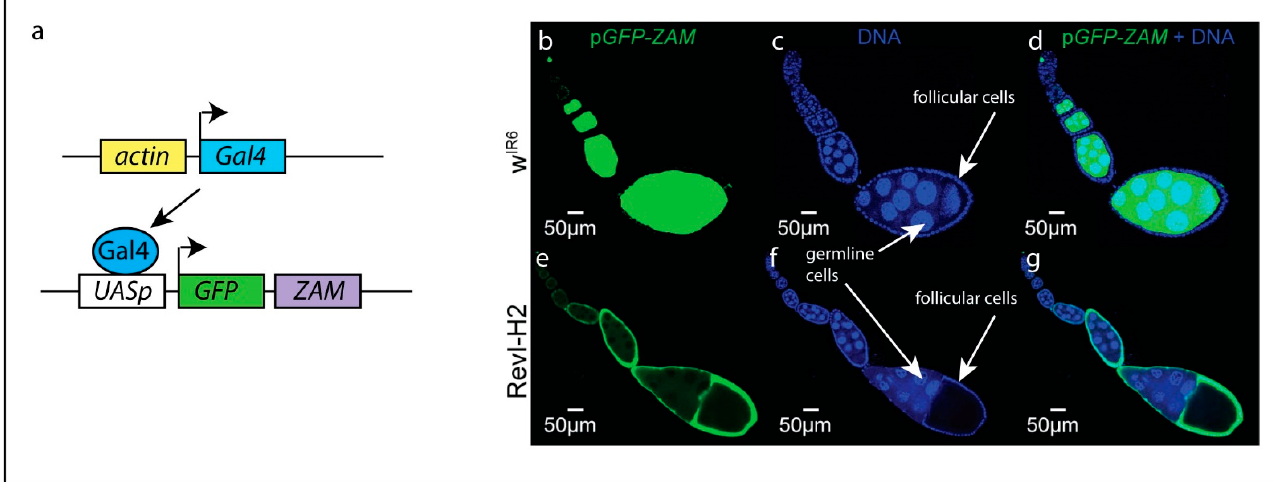
Figure 2. Regulation of the retrotransposon ZAM by piRNAs. ( a ): Principle of the ZAM sensor. Expression of the trans- activator Gal4 is ubiquitously driven by actin regulatory sequences. The GFP coding sequence is fused to a fragment of the ZAM env region and placed under the control of UAS sequences and a minimal promoter. ( b – g ): Expression of the ZAM sensor in ovaries of control flies ( w IR 6 ) or in flies with a deletion in flamenco and a de novo insertion of ZAM in a pre-existing dual strand cluster ( RevI-H2 ) ( b , d , e , g ). In w IR 6 , the sensor is silenced by the uni-strand piRNA cluster flamenco in somatic follicular cells and expressed in the germline ( b , d ). On the opposite, in RevI-H2 , the sensor is expressed in the somatic follicular cells due to the mutation in flamenco and silenced in the germline due to the ZAM insertion in the dual strand cluster ( e , g ). Origin of the photographs: Courtesy of Emilie Brasset [45] (http://creativecommons.org/li- censes/by/4.0/ accessed 2 September 2021). In blue: Staining of DNA with DAPI. In green: GFP-ZAM.